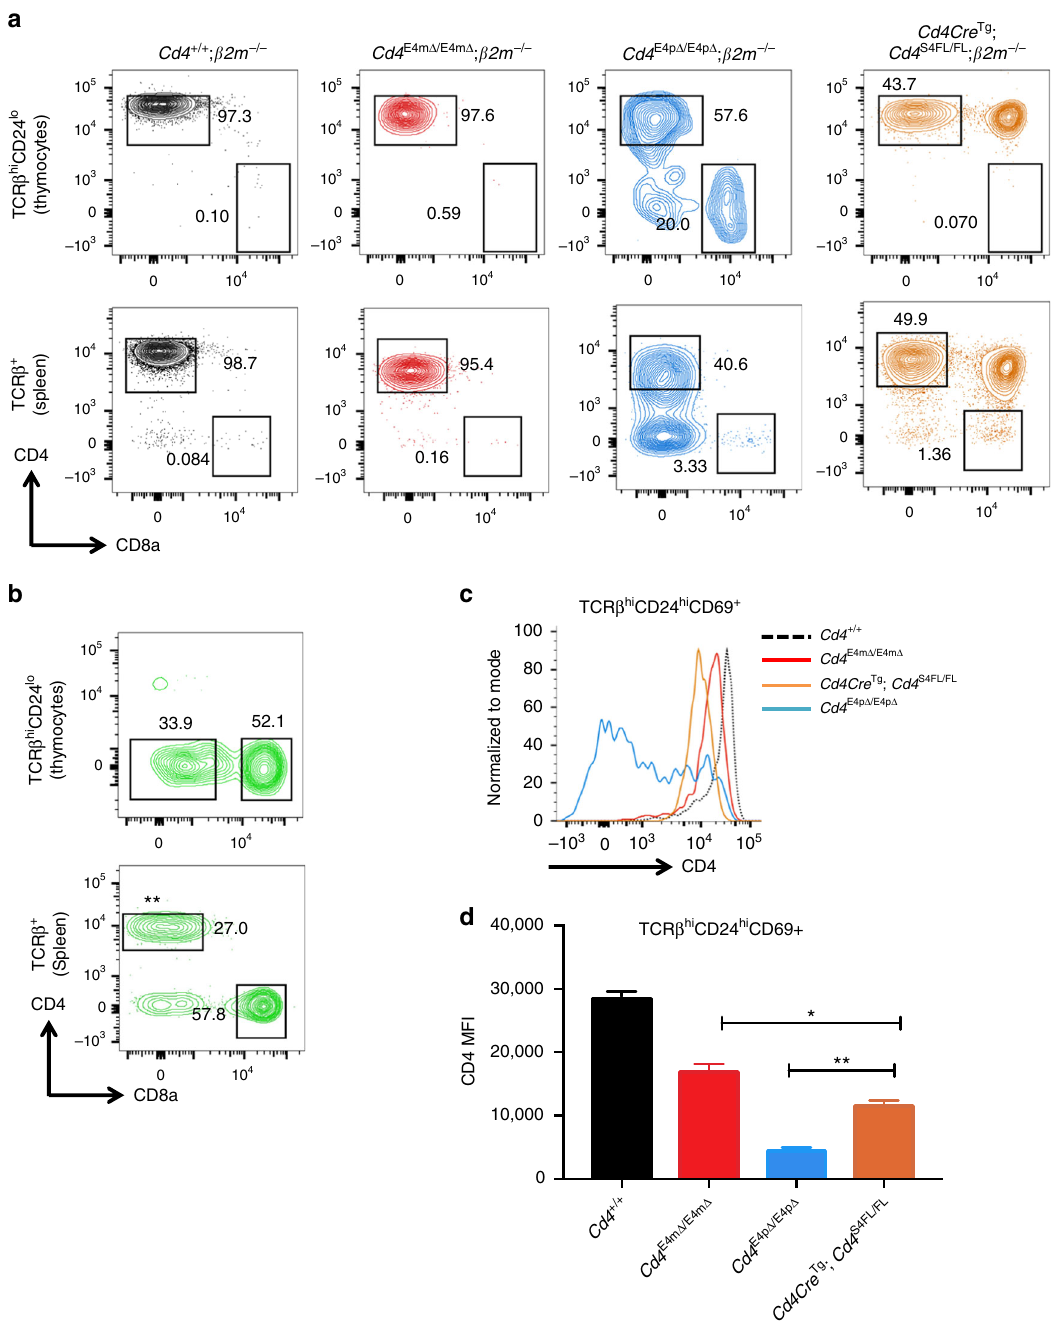
Fig. 3 Cd4 expression during positive selection is critical to prevent lineage re-direction. a CD4 and CD8 expression in indicated cell subsets and genotypes. Numbers in the FACS plot quadrants indicate cell percentages. Representative results of three independent analyses with multiple mice. b CD4 and CD8 expression on indicated cell types, 8 weeks post transfer of Cd4 − / − bone marrow into lethally irradiated β 2m − / − hosts. ** represents un-depleted CD4 + T cells in the periphery of β 2m − / − hosts. Experiment was performed three times with two or more mice each time. c Histogram showing Cd4 expression on TCR β hi CD24 hi CD69 + thymocytes of mice with the indicated genotypes. Data are representative of three independent experiments with multiple mice. d Graph quantifying the MFI of CD4 on recently selected thymocytes from mice shown in c . Data are representative of three independent experiments, with each experiment consisting of two mice in each group. Mean + SD. * p < 0.05, ** p < 0.01 (unpaired Student's t-